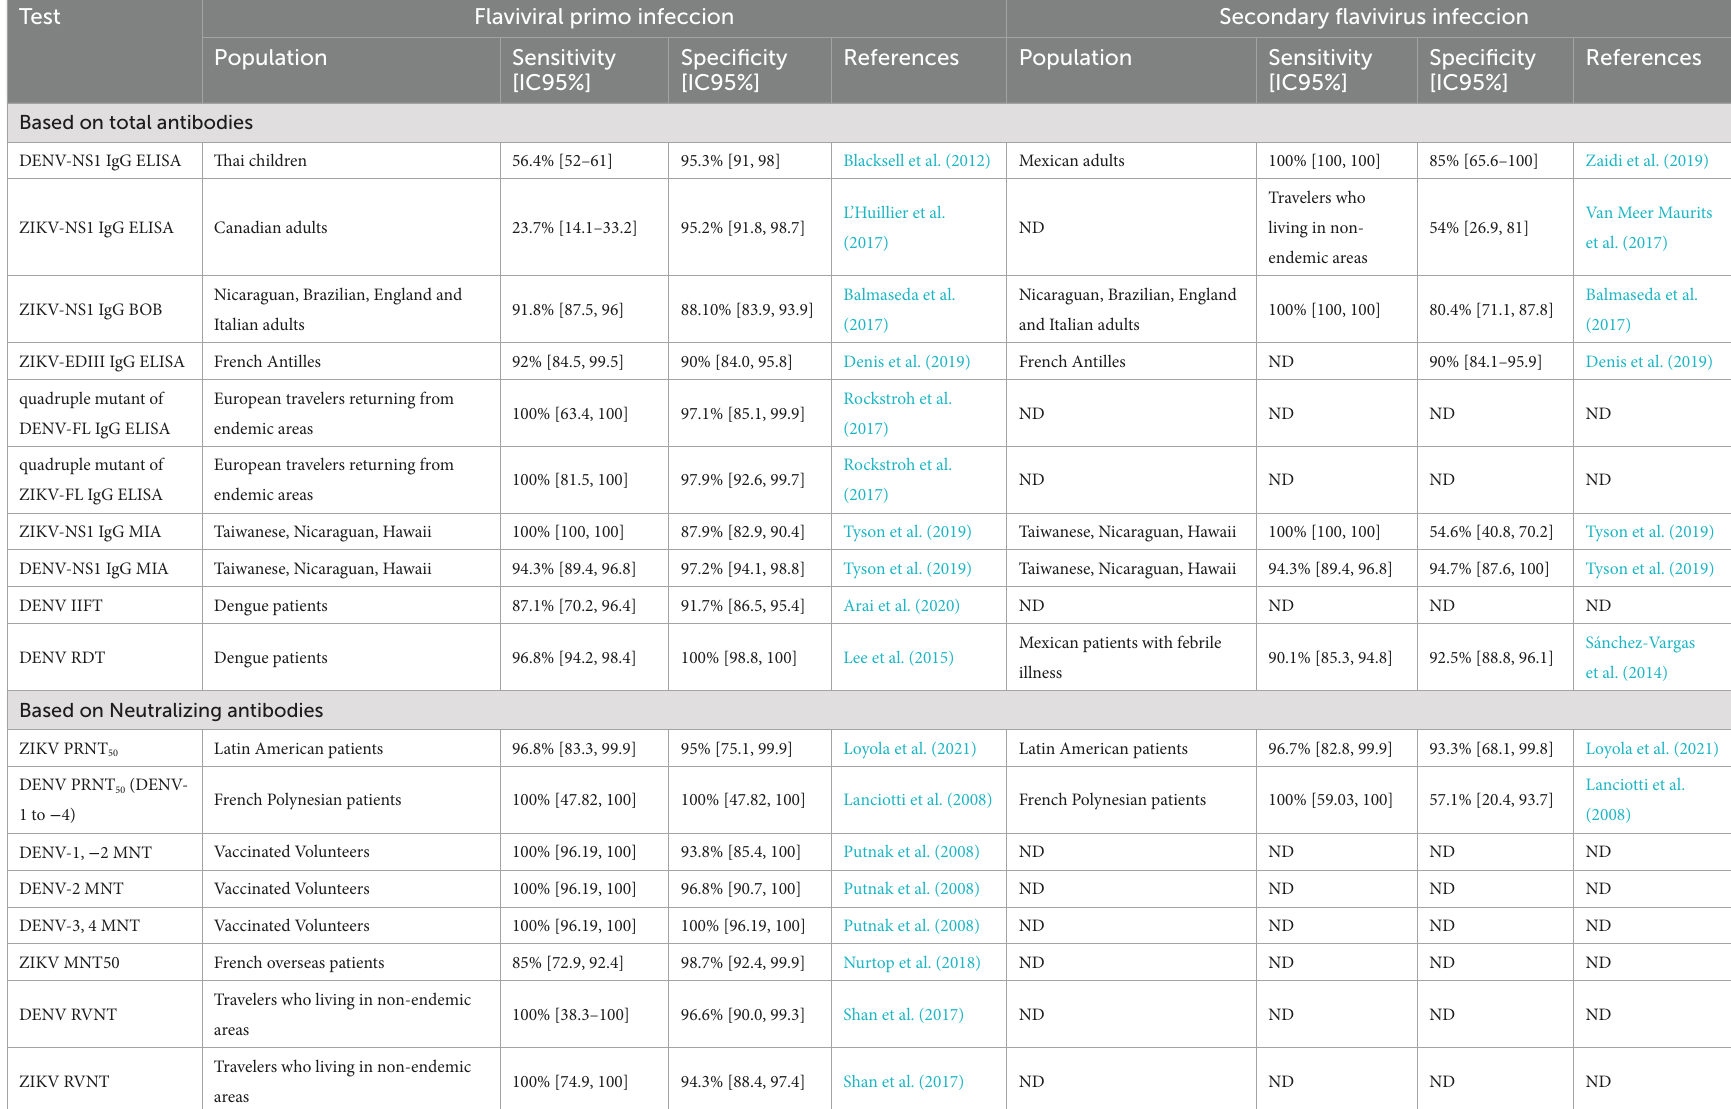
TABLE 1 Diagnostic sensibility and specificity of dengue and Zika serological tests obtained in endemic and non-endemic